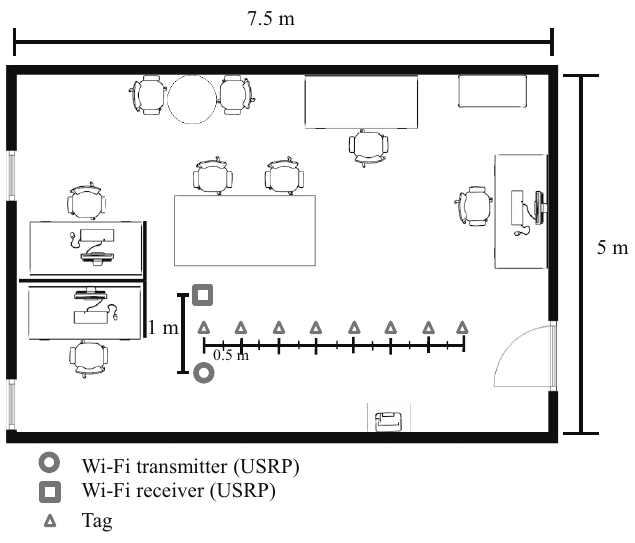
Figure 7. Experimental setup for evaluation with various tag